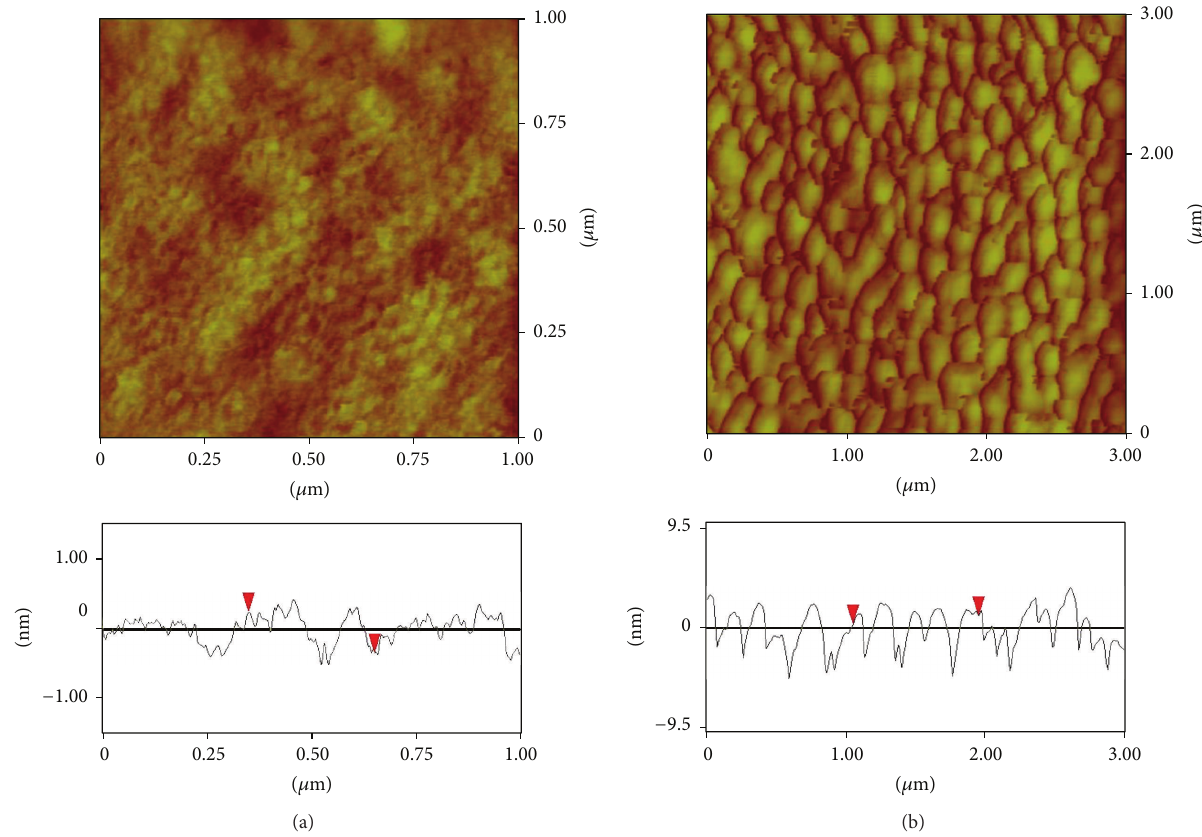
Figure 5: Topographic AFM images of (a) PCz3TB :PCBM and (b) PCz3TBTz-1 :PCBM